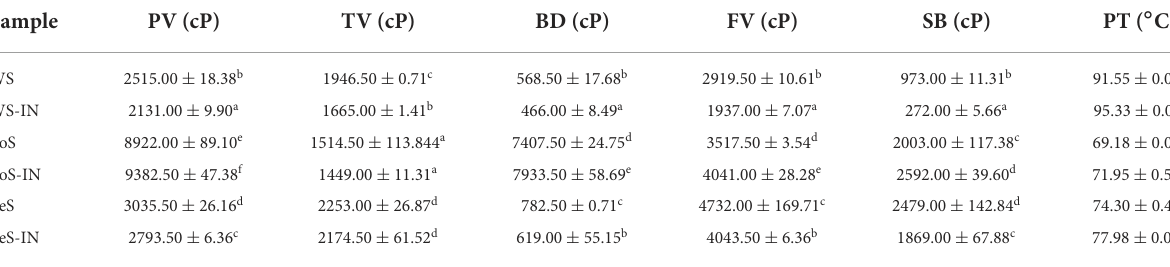
TABLE 1 The pasting parameters of inulin-different crystalline starch compound